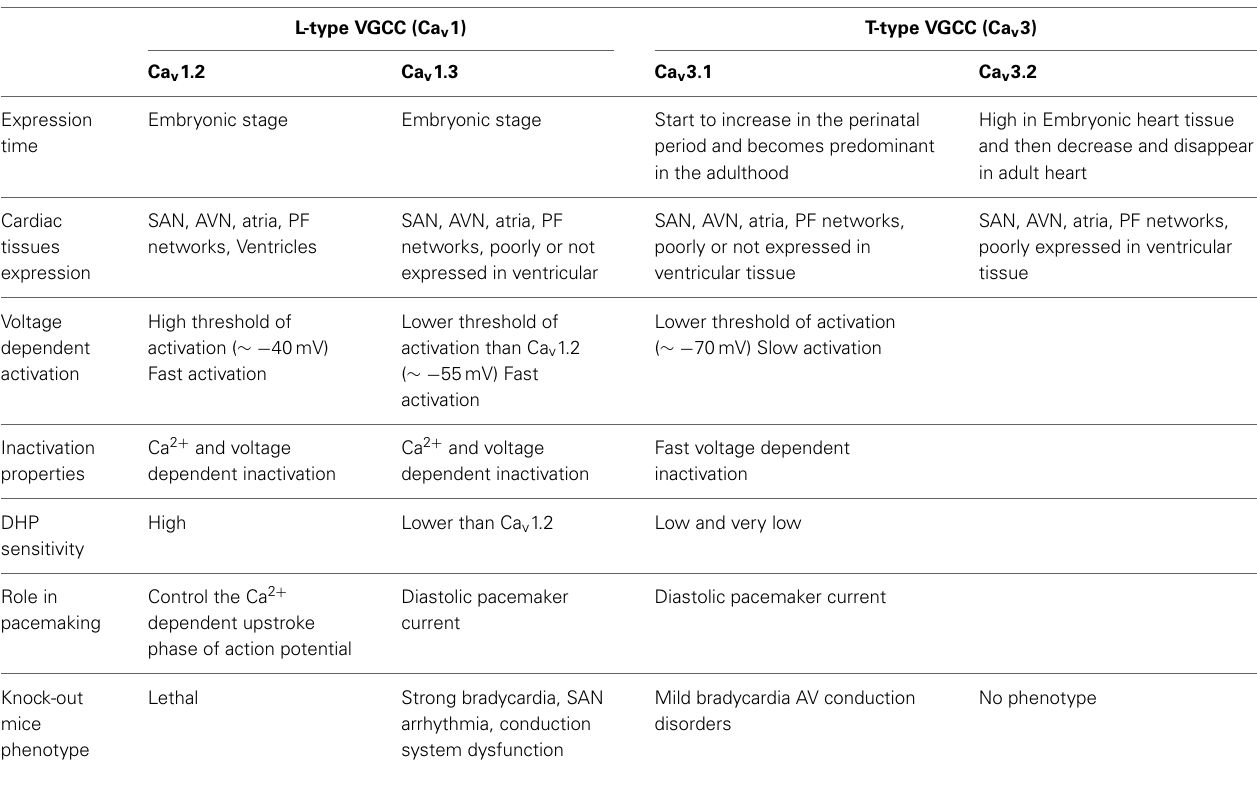
Table 1 | Characteristics of the L- and T-type VGCCs isoforms involved in cardiac